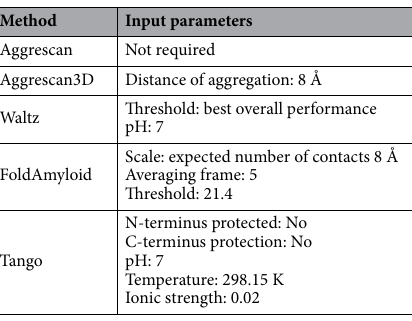
Table 2. Input parameters for each method employed to predict amyloidogenic regions within 3F12E7 scFv amino acid